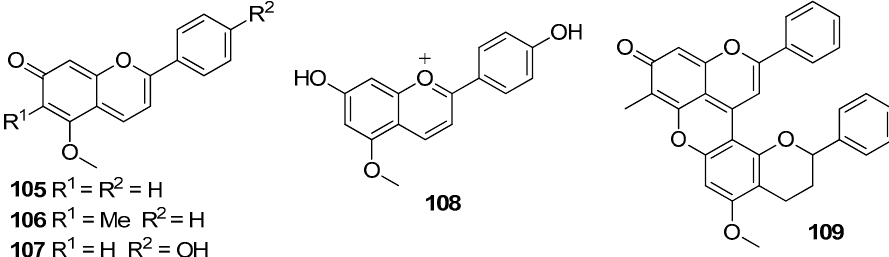
Figure 17. Chemical structures of compounds 105 – 109 responsible for the red color of dragon’s blood resin from Dracaena species.